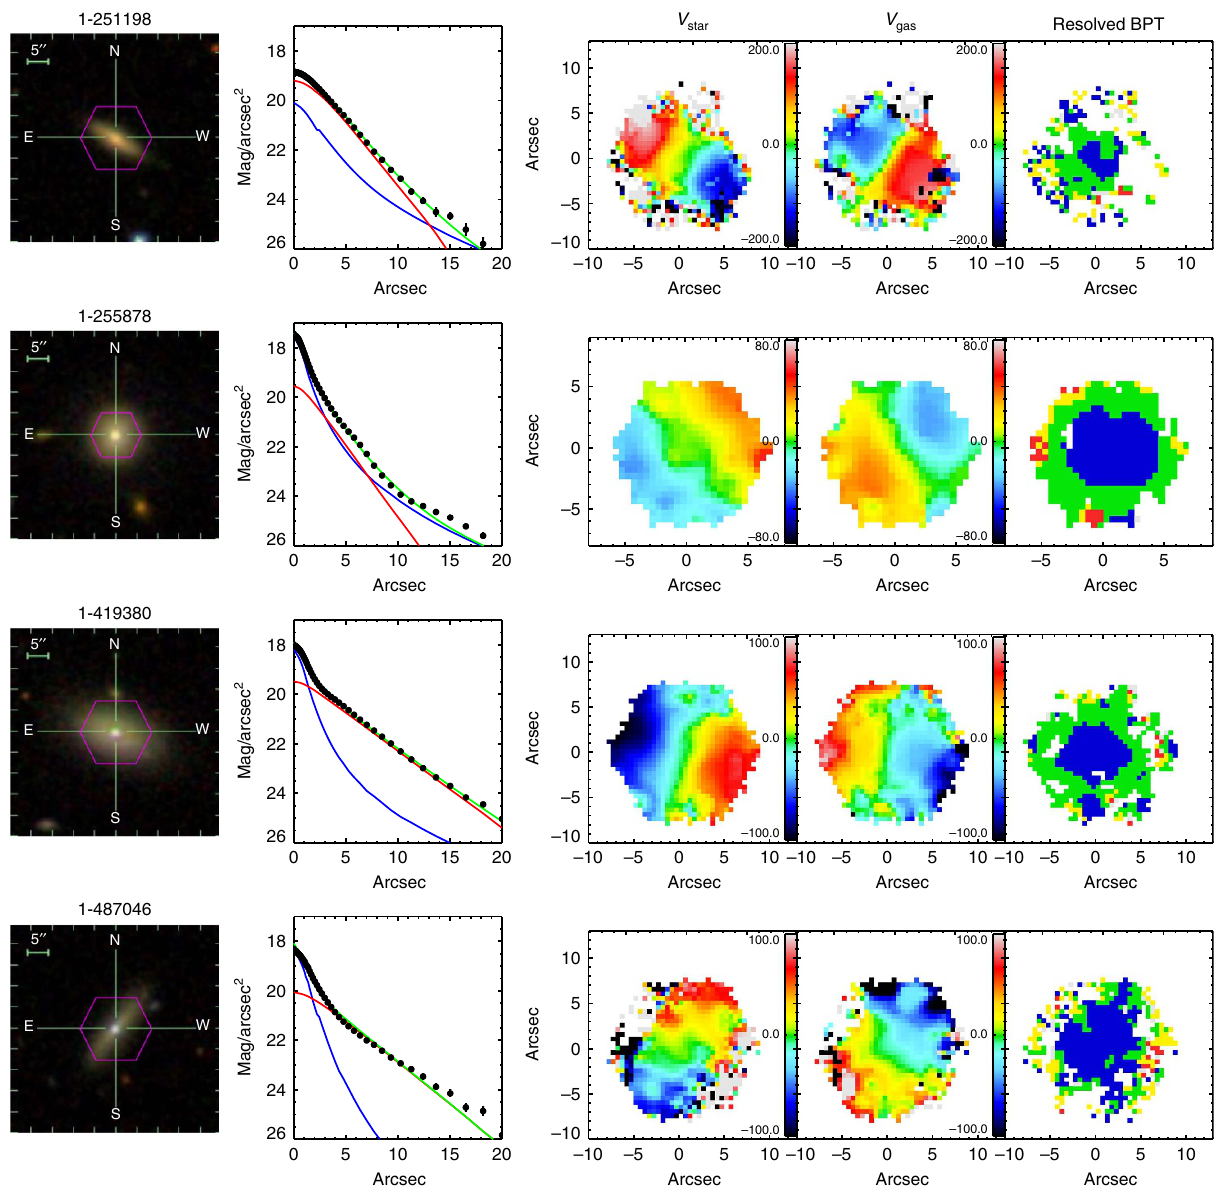
Figure 7 | Properties of the blue counter rotators. Same as Fig. 6, but with more objects. red (red histogram) and green (green histogram) subsamples, as well as the nine blue counter rotators (cyan histogram). Sample completeness correction . An issue with every data set is the selection of weights to correct for missing galaxies. The MaNGA target sample is selected to lie within a redshift range, z min o z o z max , that depends on absolute i —band magni- tude in the case of the Primary and Secondary samples, and absolute i —band magnitude and NUV — r colour in the case of the colour-enhanced (CE) sample. z min and z max are chosen to yield both the same number density of galaxies and angular size distributions, matched to the IFU sizes, at all absolute i —band mag- nitudes (or magnitudes and colours for the CE sample). This results in lower, and narrower, redshift ranges for less luminous galaxies and higher and wider redshift ranges for more luminous galaxies. At a given M i (or M i and NUV — r colour for the CE sample) the sample is effectively volume limited in that all galaxies within z min ( M i ) o z o z max ( M i ) are targeted irrespective of their other properties. However, that volume varies with M i . Therefore in any analysis of the properties of MaNGA galaxies as a function of anything other than M i we must correct for this varying selection volume, V s ( M i )— the volume with z min ( M i ) o z o z max ( M i ). The simplest approach is just to correct the galaxies back to a volume-limited sample by applying a weight ( W ) to each galaxy in any calculation such that W ¼ V r / V s , where V r is an arbitrary reference NATURE COMMUNICATIONS|7:13269|DOI: